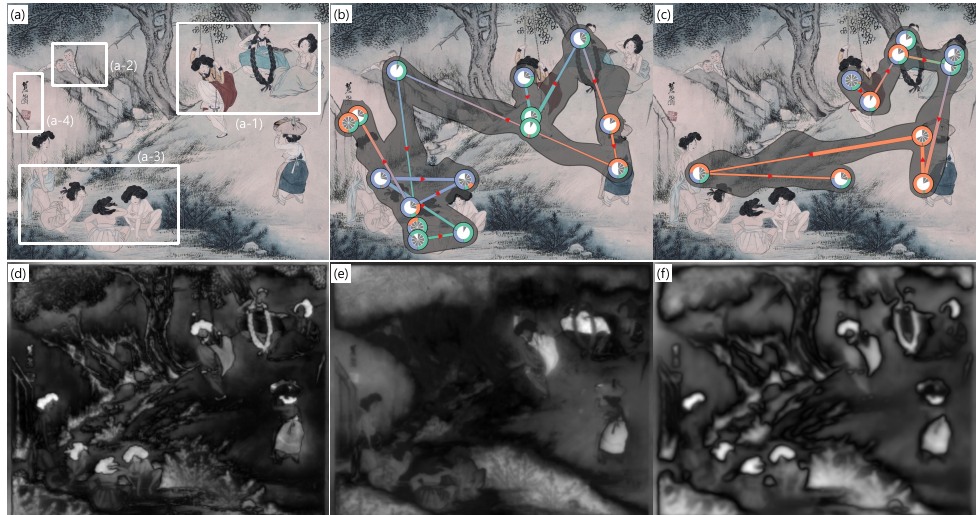
Figure 5. Gaze analysis on a painting. ( a ) is the visual stimulus. ( b , c ) are the saliency-based gaze visualizations of two participants. ( d – f ) are the intensity, color, and orientation feature map, respectively. The visual stimulus in ( a ), “A Dano festival”, is provided by Kansong Art and Culture Foundation in Seoul, South